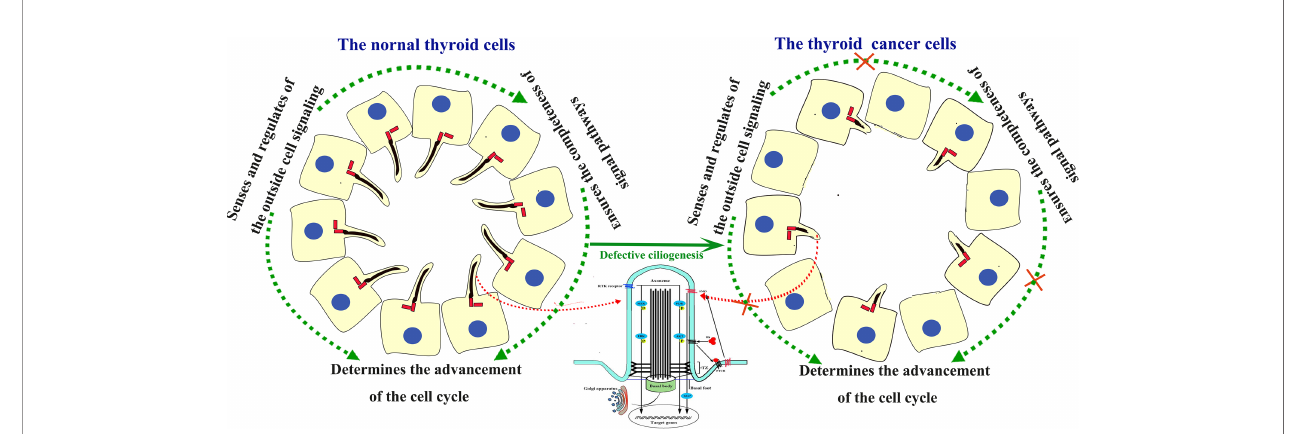
FIGURE 1 | Structure of the PC and signaling pathways involving cilia in the human thyroid gland and TC. In normal thyroid gland cells, the PC acts as the sensor and regulator of the outside cell signaling. In TC cells, the PC was absent. Absence of the PC block the signal from outside and neighbors, and disturb the signal pathways inside cells, thus lead to uncontrolled cell cycle process and